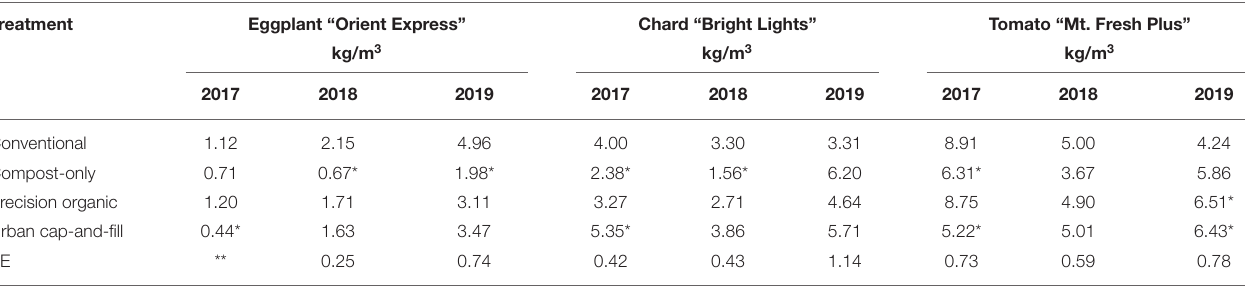
TABLE 2 | Marketable system yield and value of system production by year and pooled across years when the treatment-by-year interaction was not significant ( p > 0.05). Treatment